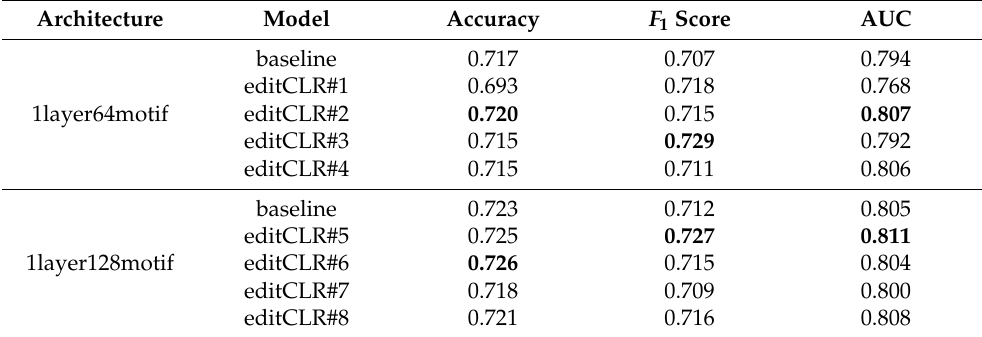
Table 4. The average results of 8 sampled pre-trained editCLR models transferred to 20 datasets. Architecture Model Accuracy F 1